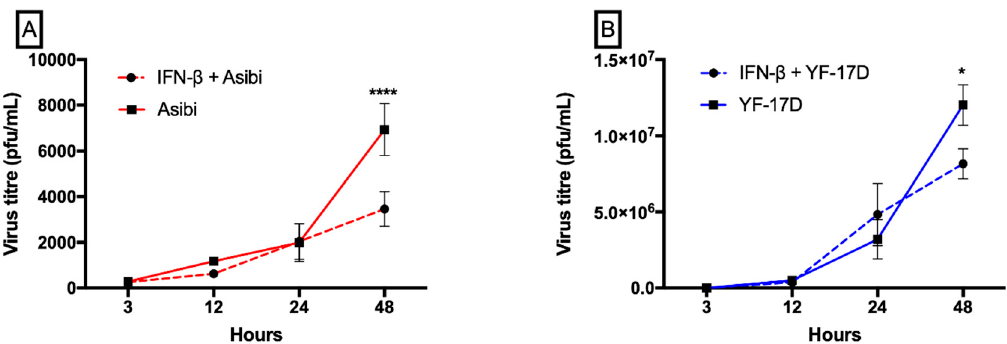
Figure 1. Interferon- β limits the replication of both Asibi and YF-17D viruses at later time points. HeLa cells were either stimulated or not with IFN- β for 6 h and were either infected with Asibi ( A ) or YF-17D ( B ) at MOI = 1. Culture supernatants were aspirated at indicated time points and viral titre determined by plaque assay. Result is indicative of two independent experiments performed in duplicates. Data are presented as mean ± SEM. * = p ≤ 0.05, **** = p ≤ 0.0001. IFN = interferon- β .